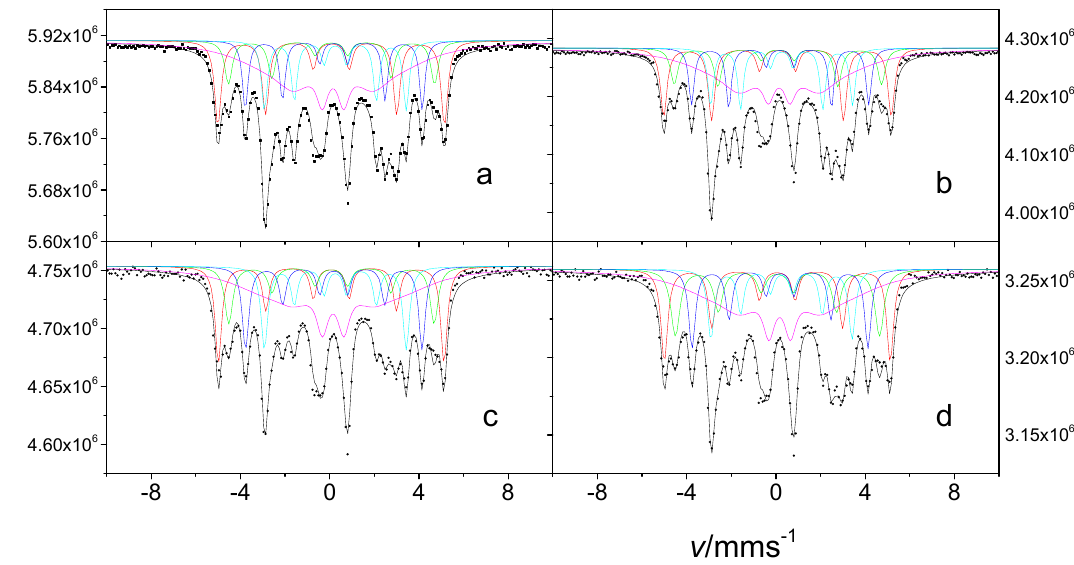
Figure 2. Room temperature transmission 57 Fe Mössbauer spectra of FINEMET samples CK021 ( a , c ) and CK022 ( b , d ), non-irradiated ( a , b ) and after their first irradiation by 160 MeV 132 Xe ions at a fluence of 10 13 ion cm − 2 ( c , d ) from the air side direction.